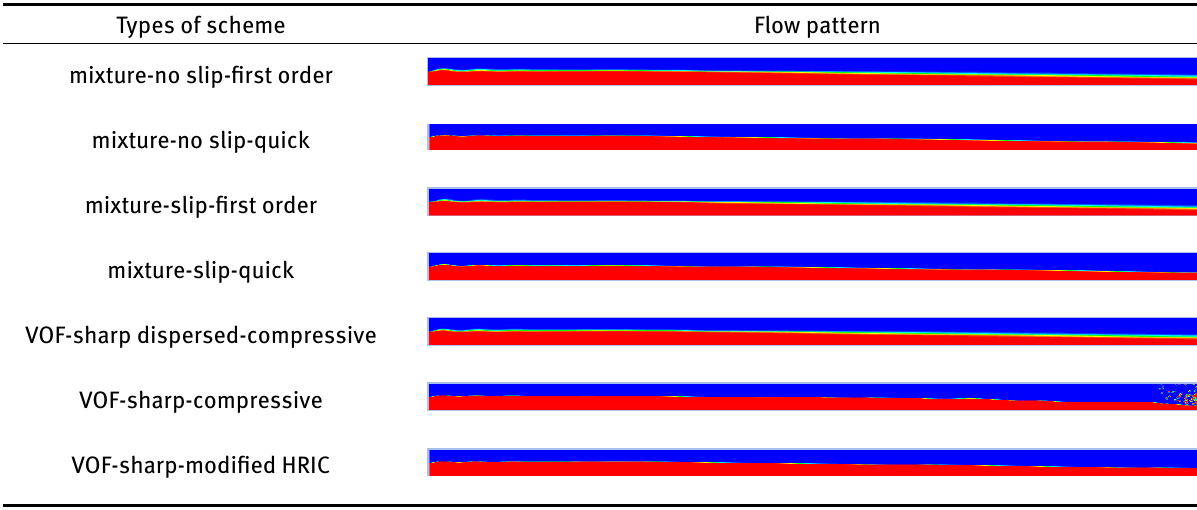
Table 13: Inlet the kerosene above the water for two-phase flow patterns, (L = 3 m, H = 10 cm), mesh (1,040,000) Types of scheme